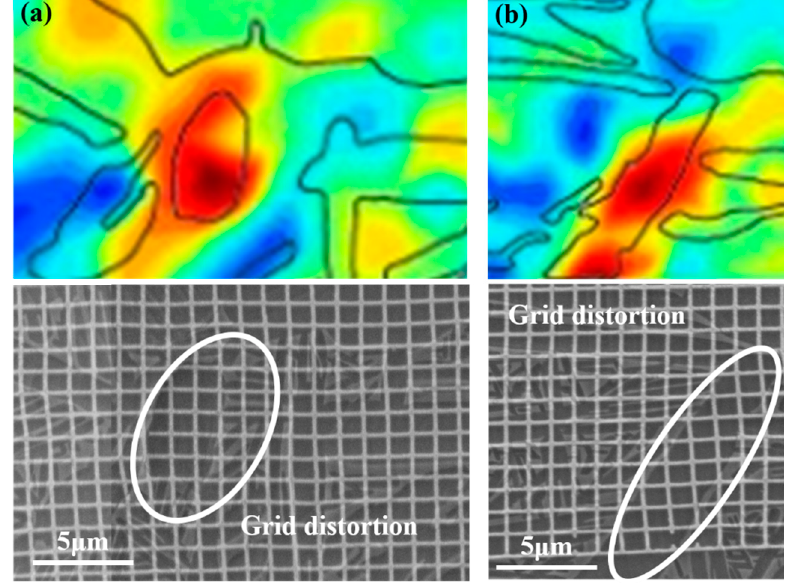
Figure 7. The typical strain localization regions and corresponding grid change within equiaxed α ( a ) and within lamellar α ( b ) at macro-strain of 4.7%.